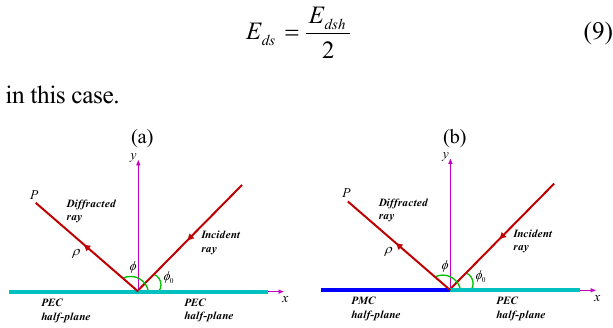
FIGURE 3. The diffraction geometry a) by a planar junction between PEC and PEC half-planes, b) by a planar junction between PEC and PMC half- planes.